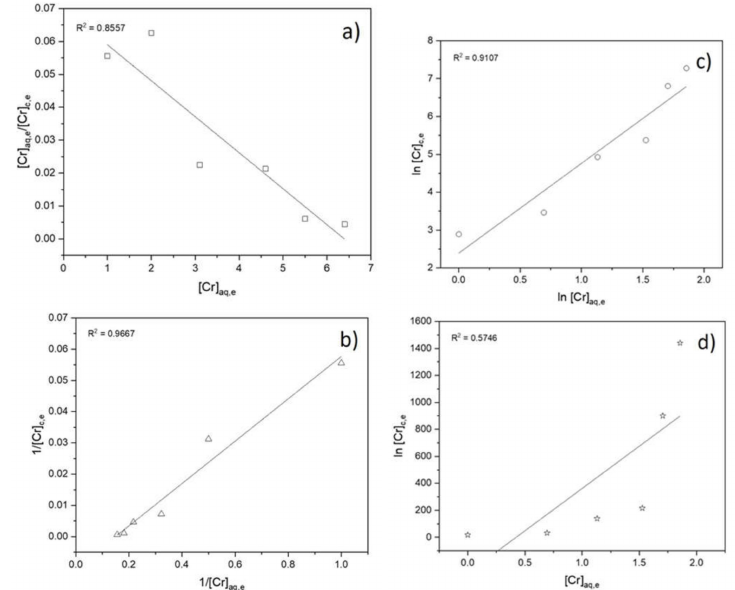
Figure 7. Linearized Type-I Langmuir ( a ); Type-II Langmuir ( b ); Freundlich ( c ); and Temkin ( d ) adsorption isotherms.